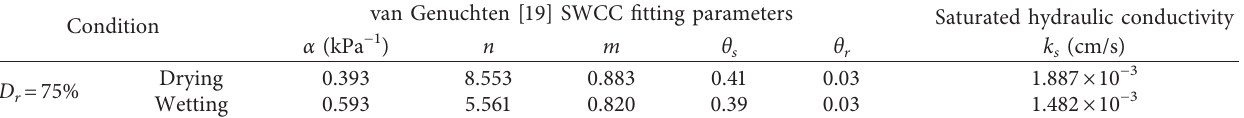
Table 2: Unsaturated soil parameters of Jumunjin standard sand with a relative density of 75%. Condition